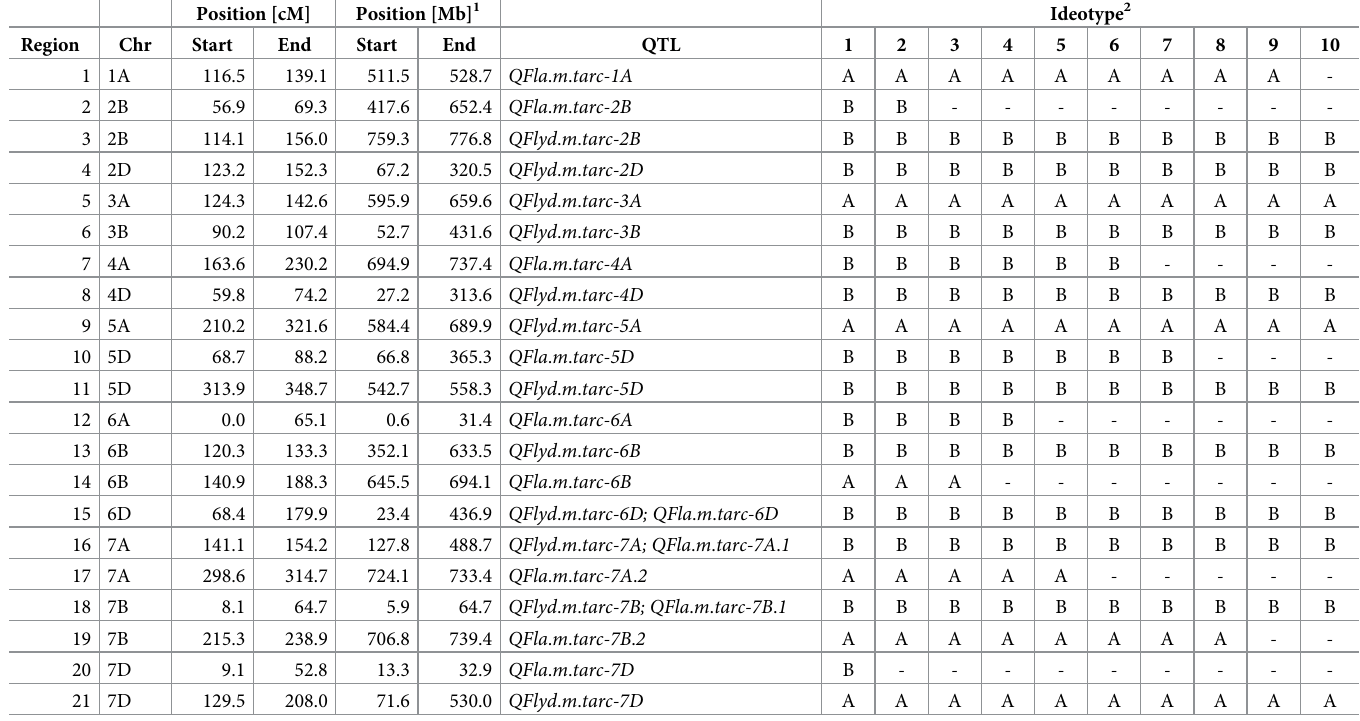
Table 6. Genotypes of the ten ideotypes used for simulation. Position